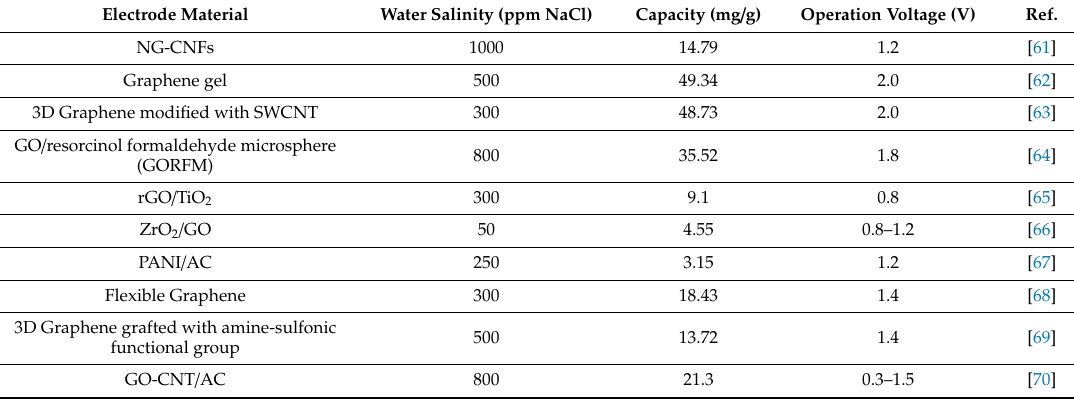
Table 3. Some recent advances in electrode modifications for capacitive